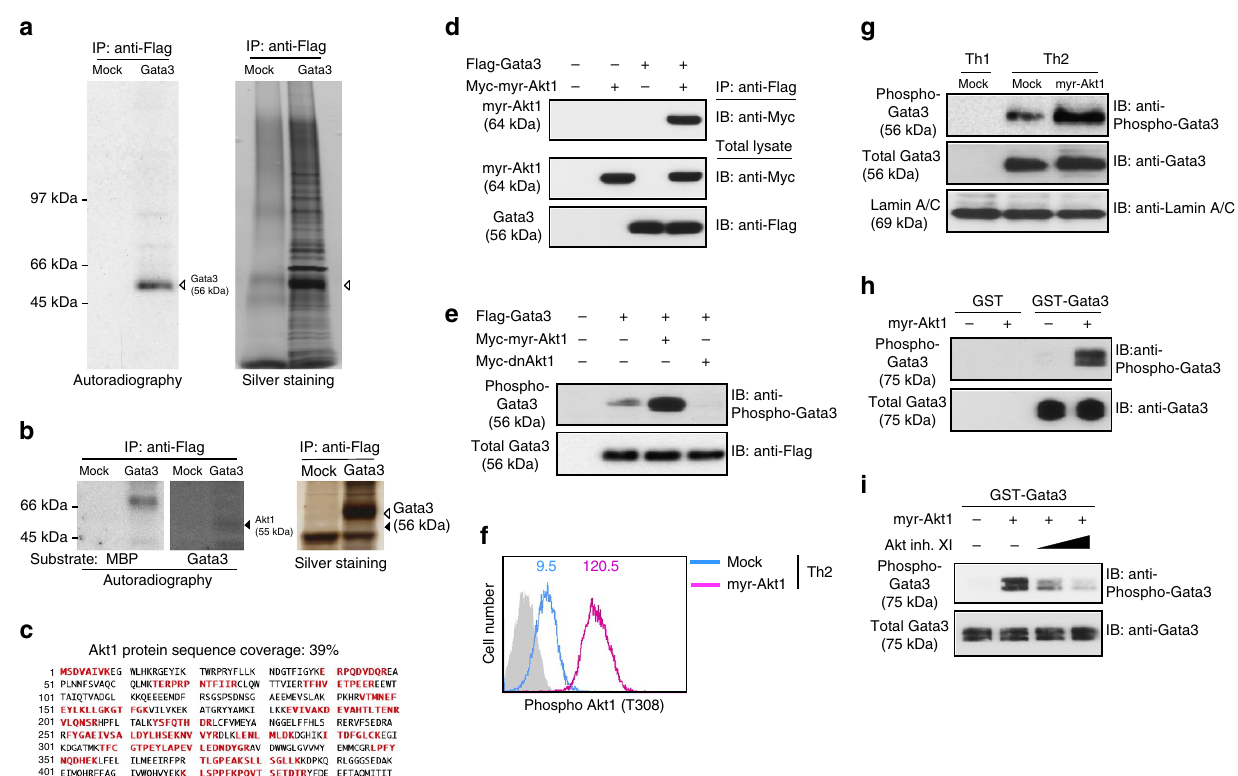
Figure 4 | Akt1 is a kinase for Gata3 phosphorylation. ( a ) Immunopurified Gata3 complexes from 293Tcells were subjected to an in vitro kinase assay. The white arrowheads indicate the molecular size of Gata3. ( b ) Immunopurified Gata3 complexes from 293T cells were run on a 12% SDS–PAGE gel containing recombinant Gata3 or myelin basic protein (MBP), followed by an in-gel kinase assay. Black arrowheads indicate the molecular size of Akt1. ( c ) Akt1 is detected from the band identified in Fig. 4b. Representative sequence coverage of Akt1 protein detected in a mass spectrometry analysis is shown. Red characters indicate the actual peptides detected by mass spectrometry. ( d ) The association of Myc-tagged myr-Akt1 with Flag-tagged Gata3 was assessed using 293T cells. ( e ) The amounts of phospho-Gata3 were assessed by IB with a phospho-Gata3 Ab or a Flag mAb using total lysates from Flag-tagged Gata3 and myr-Akt1 or dn Akt1-expressing 293Tcells. ( f , g ) Naive CD4 T cells were stimulated under Th2 conditions and then infected with a retrovirus vector carrying myr-Akt1 cDNA. Four days later, intracellular staining profiles of phospho-Akt1 (Thr308) are shown. The number in the histogram represents the MFI. The grey-filled histogram shows isotype control staining ( f ). The amount of phospho-Gata3 was assessed by IB ( g ). ( h , i ) Recombinant Gata3 was subjected to an in vitro phosphorylation assay using immunopurified myr-Akt1 from 293Tcells with or without Akt inhibitor XI. Five ( e ), four ( a , h ), three ( d , i ) and two ( b , f , g ) independent experiments were performed with similar